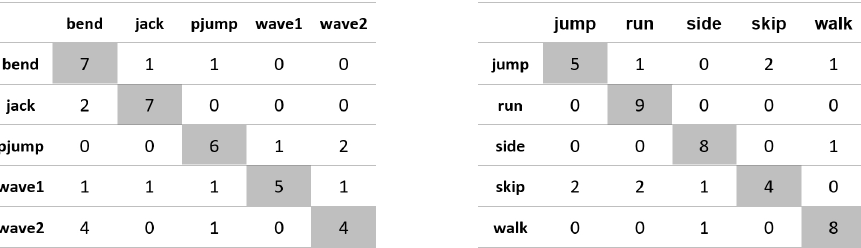
Figure A31. Confusion matrices for the experiment using the ‘upper-occlusion’ database, MBR width and C1 correlation.